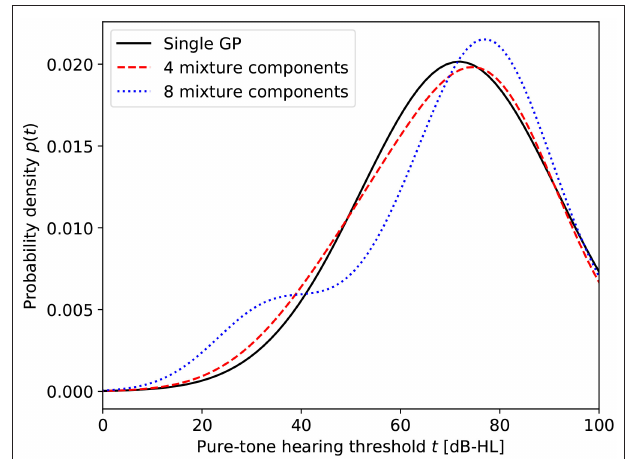
FIGURE 4 | Probability distributions of the HT at 8 kHz for different numbers of mixture